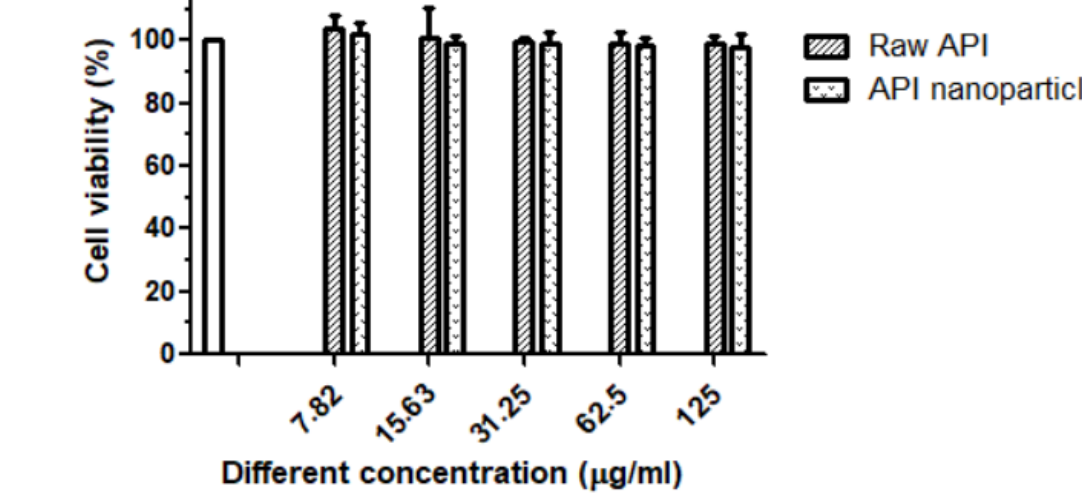
Figure 10. Cell proliferation percent inhibition of raw API and API nanoparticles on RAW264.7 cells.